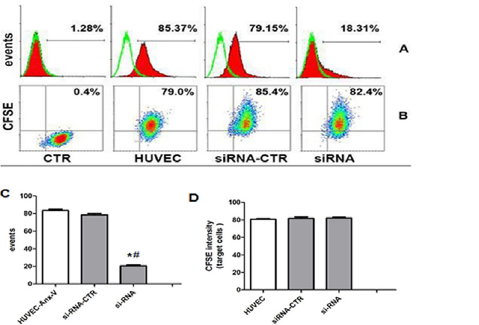
Fig 7. Down-regulation of Anx-V in HUVECs has little effect on the MSC-MV internalization. (A) Anx-V siRNAs were transfected into HUVECs and the Anx-V expression was assessed by flow cytometry. The hollow diagrams represent the control and the solid ones represent the Anx-V-FITC fluorescence intensities of the indicated cells. (B) HUVECs, Anx-V siRNA-transfected HUVECs (siRNA) and control siRNA- transfected HUVECs (siRNA-CTR) were maintained in culture for 12 hours in the presence of CFSE-labeled MSC-MVs. The cells were harvested for flow cytometric analysis. (C) The t-test shows that the Anx-V expression was significantly decreased by si-RNA ( vs .CTR * P < 0.001; vs .siRNA-CTR # P < 0.001). (D) Anx-V did not effect the internalization of MVs ( vs .CTR P = 0.83). These results are representative of the data from three separate